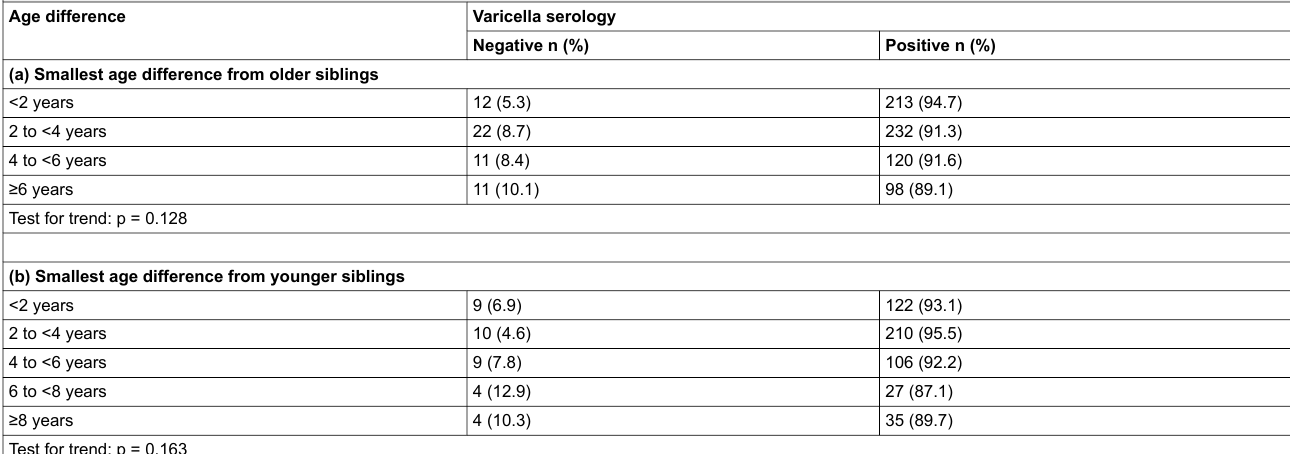
Table 2: Does age difference between siblings influence varicella seropositivity in travellers seeking pre-travel advice at the Travel Clinic of the University of Zurich between December 2008 and August 2015 who had an uncertain or negative varicella history (n = 1757)? Varicella serologyAge